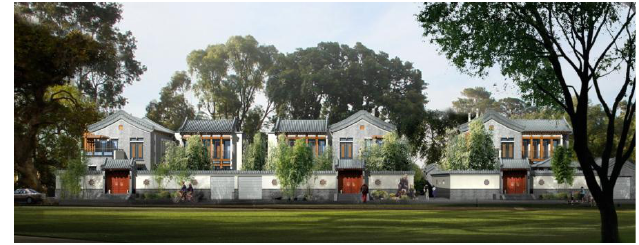
Figure 10. Computer-rendered façade of Guantang courtyard garden villas, showing traditional Beijing architectural features and colors. Source: Beijing Institute of Architectural Design 2014.